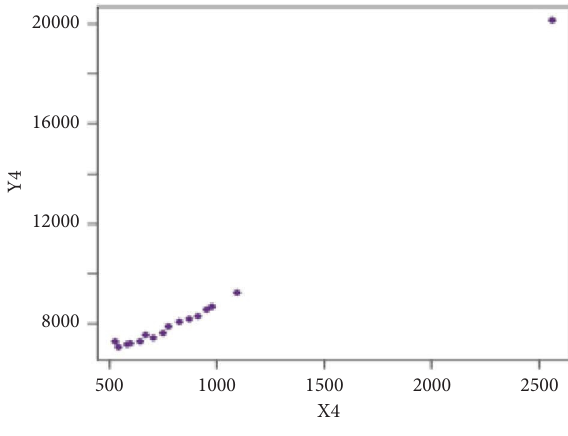
Figure 4: Stratum-IV (population-1). Table 1: Population-1 characteristics.